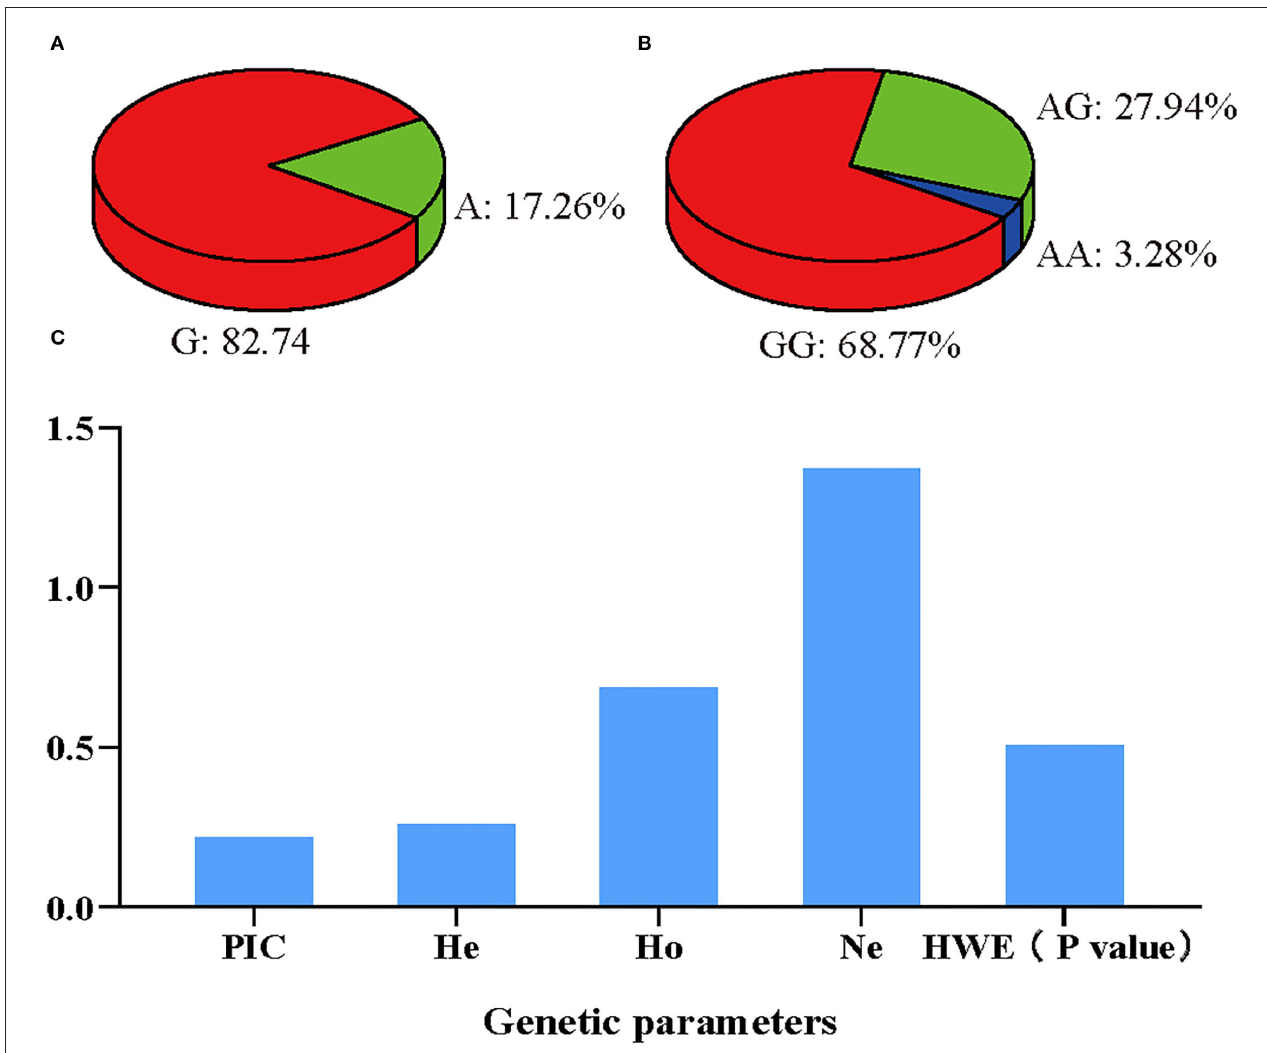
FIGURE 6 | Gene frequency and genetic parameters of IL18 g. 24991651A > G in Hu sheep population. (A) Allelic frequency of IL18 g. 24991651A > G site. (B) Genotypic frequency of IL18 g. 24991651A > G site. (C) Genetic parameters of IL18 g. 24991651A > G site. Ne, effective allele numbers; Ho, homozygosity; He, heterozygosity; PIC, polymorphism information content; HWE, Hardy–Weinberg equilibrium.